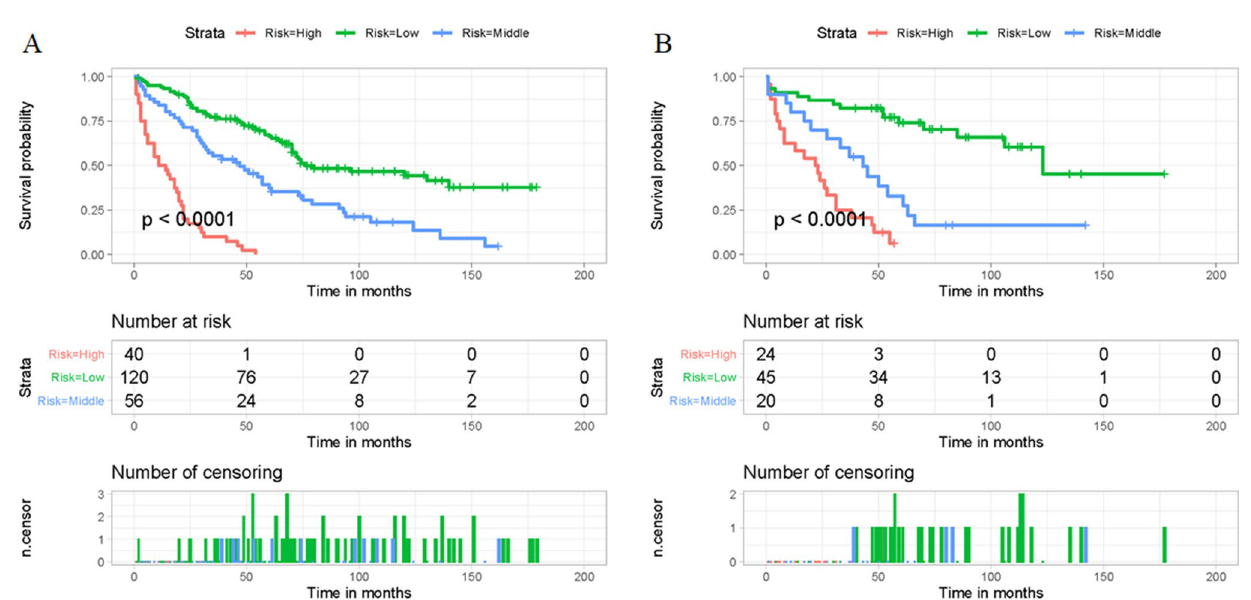
Figure 7. Kaplan–Meier survival analysis for the training ( A ) and validation sets ( B ) in this cohort retrospective study. Figure was generated by R software version 4.03 (http:// www.r- proje ct.